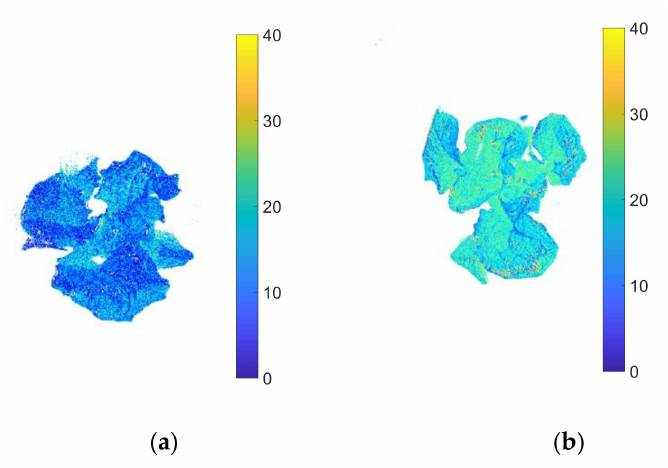
Figure 17. Moisture content distribution of lettuce canopy dry base. ( a ) Dry base water content 9.3352. ( b ) Dry base water content